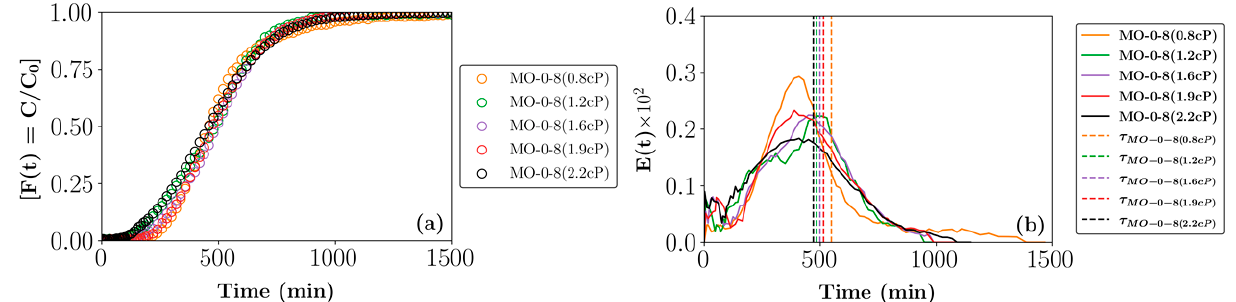
Figure 13. (Left—( a )) Cumulative (F(t)) and (right—( b )) exit age (E(t)) RTD profiles for beds composed of 0–8 mm MO particles and irrigated with different viscosity solutions (0.8. 1.2, 1.6, 1.9, and 2.2 cP). The vertical lines in the E(t) curves represent the calculated average residence times.